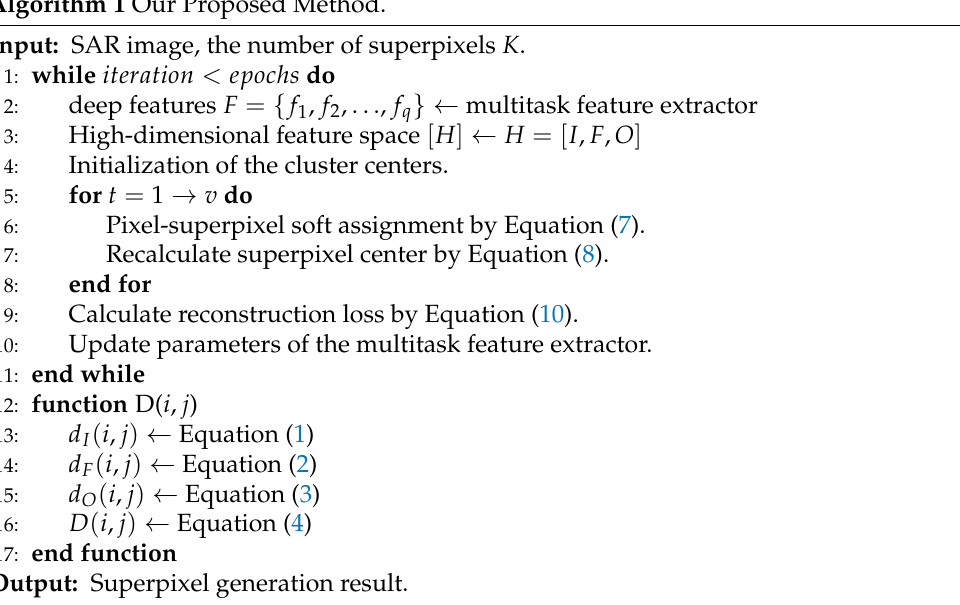
Algorithm 1 Our Proposed